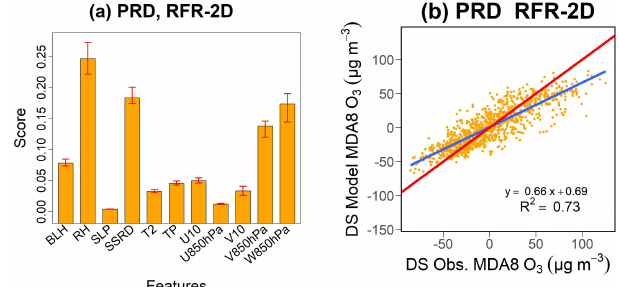
Figure 7. (a) Average PRD Gini feature importance score of each meteorological variable if the RFR regressions include non-local predictors within a 7.5 ◦ longitude × 7.5 ◦ latitude domain around the predicted grid point; the bar representations are consistent with Fig. 5. (b) Linear fit between RFR–2D predictions and observations in PRD (blue line). The red line equals the ideal 1:1